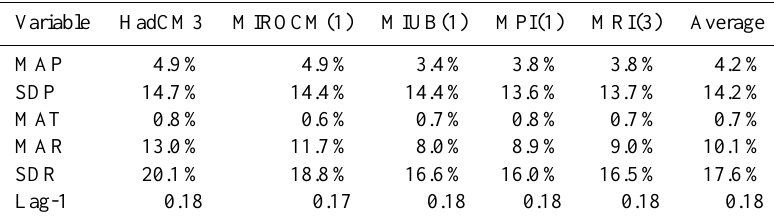
Table 6. Relative within-GCM uncertainty of mean and standard deviation of annual precipitation, mean annual temperature and mean, standard deviation and lag-1 serial correlation of annual runoff. Relative uncertainty is the standard deviation of the 100 replicate estimates as a percentage of the mean replicate estimate for each GCM during the period 2015–2044 (A1B). The average of the 17 catchment relative uncertainty values is presented, except for lag-1 annual runoff which is the average of the 17 standard deviations.